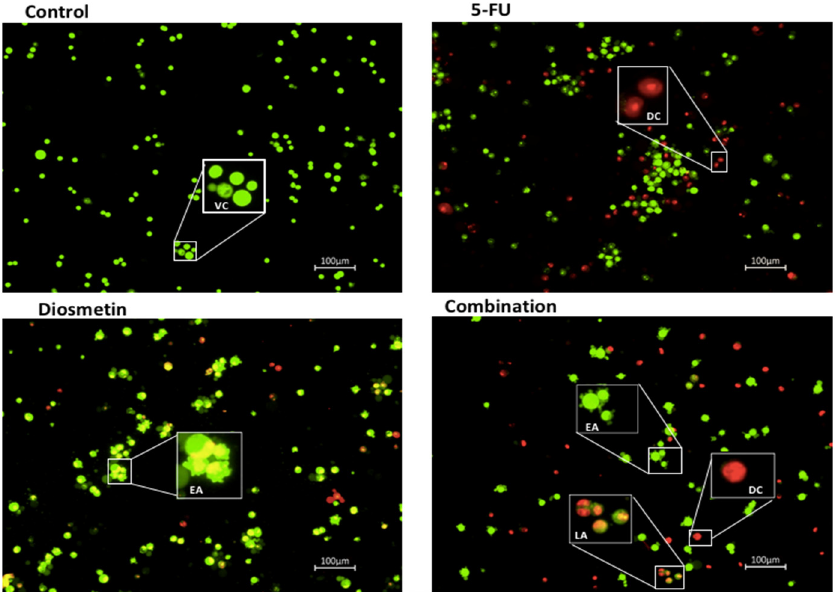
Figure 11. HCT116 cells stained with AO/PI after 72 h of treatment with the IC5 0 of monotherapy and combination therapy. The control group remained untreated. VC: viable cells (green), EA: early apoptosis (green cells with blebbing), LA: late apoptosis (orange), DC: dead cells (red). 10× magnification.